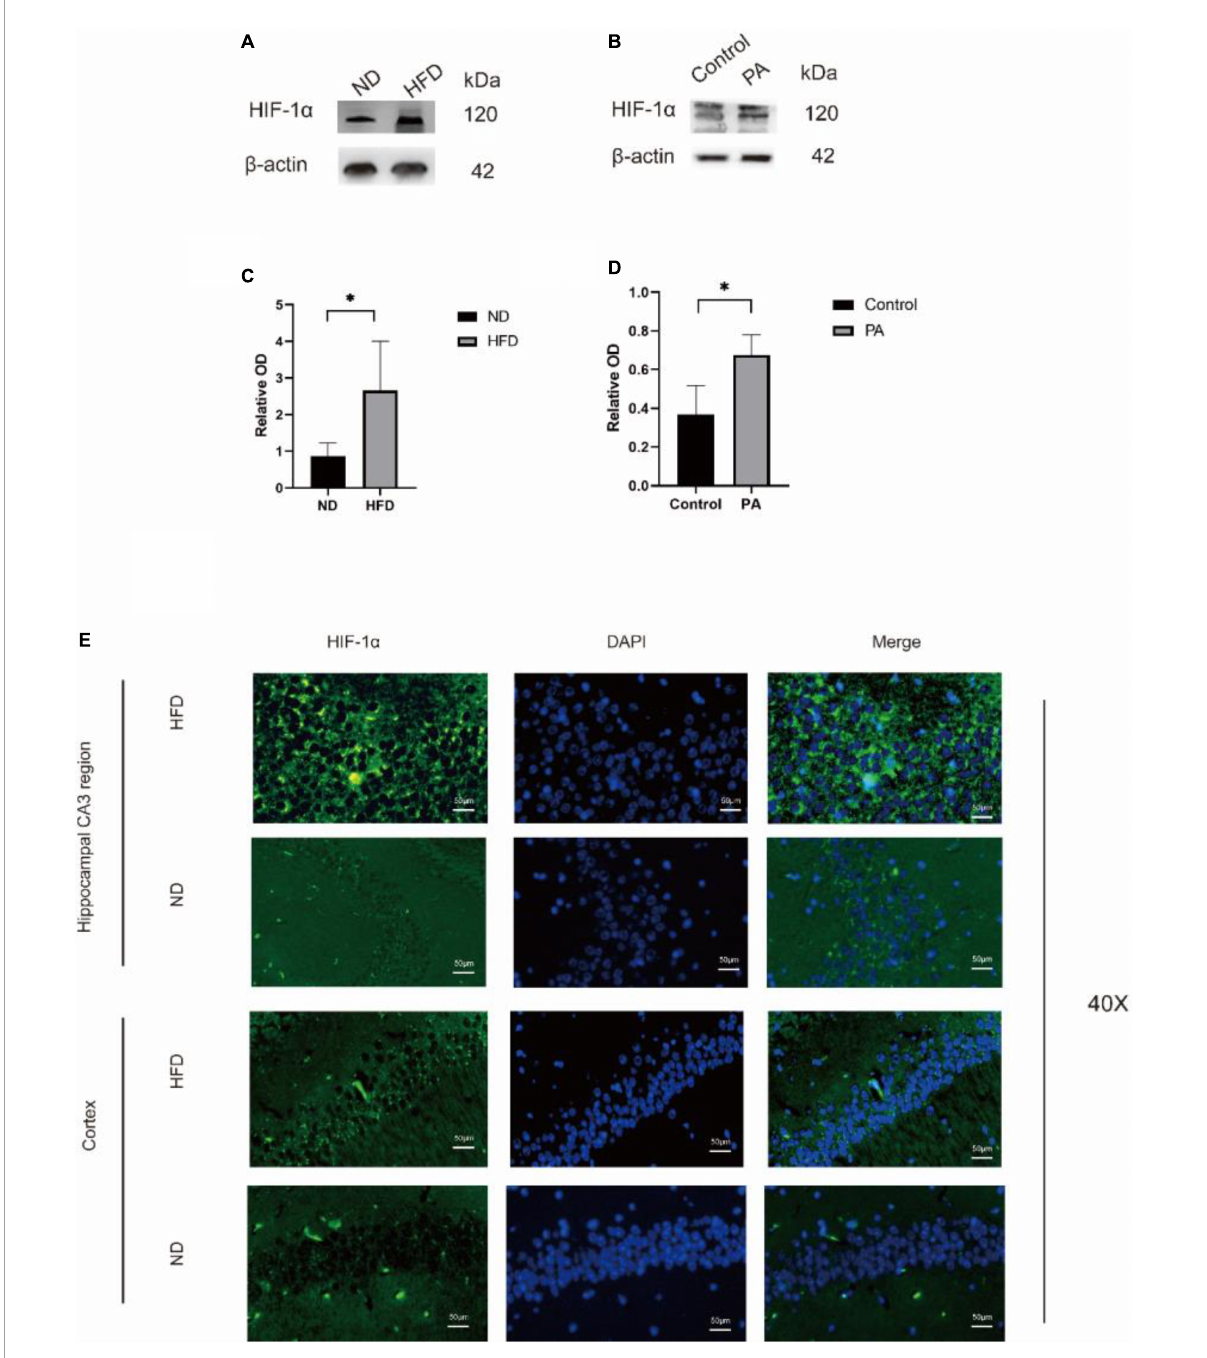
FIGURE3 The expression of HIF-1 α was observed in hippocampus of mice. Western blot results showing that high-fat diet upregulates the expression of HIF-1 α in the hippocampus of aged brain C57BL/6 mice ( n = 4/group, two-sample t -test) (A,B) . (C,D) , Graph showing the expression level of HIF-1 α proteins expressed in BV2 cells after treatment with 100 mM PA. (E) Expression of HIF-1 α in the CA3 of the hippocampus and cortex of mice in the two groups observed by immunofluorescence ( n = 3/group). Scale bars = 50 µ